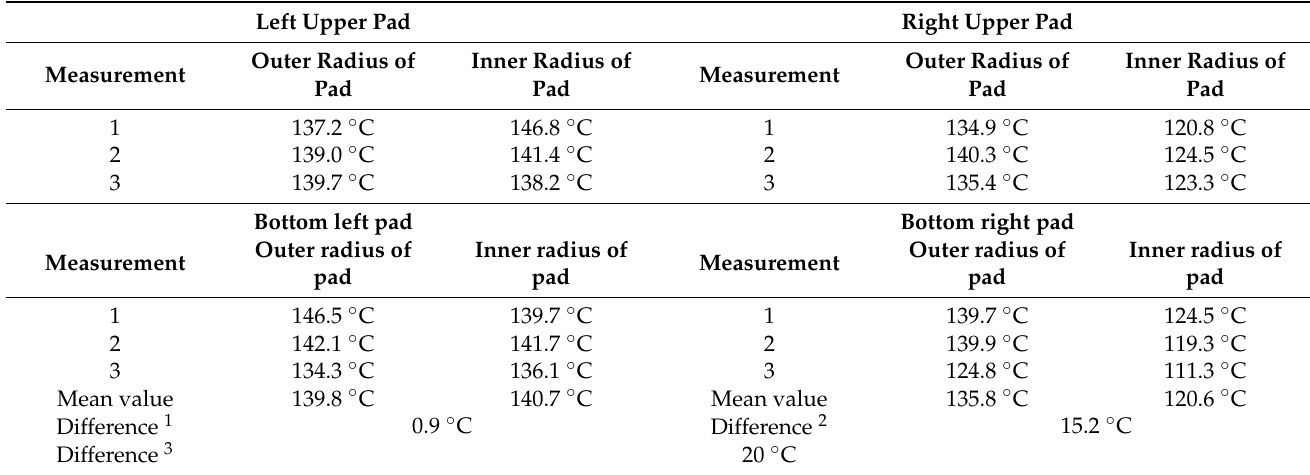
Table 6. Temperature distribution results on friction